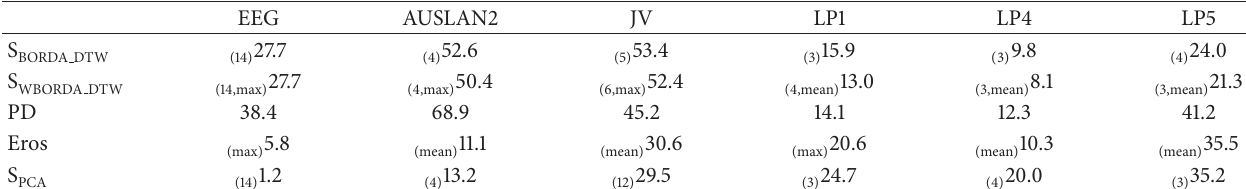
Table 2: Classification error rate (%).